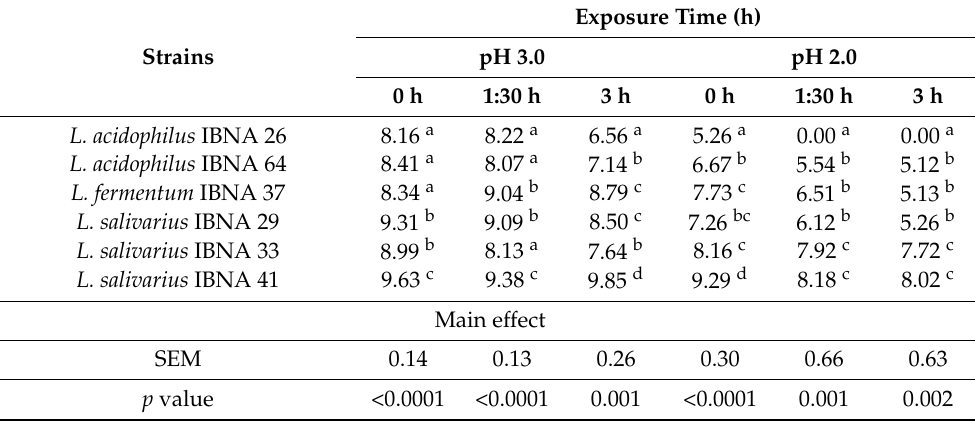
Table 3. Viability of Lactobacillus isolates during 3 h of incubation at low pH. Exposure Time (h) pH 3.0 pH 2.0 Strains 0 h 1:30 h 3 h 0 h 1:30